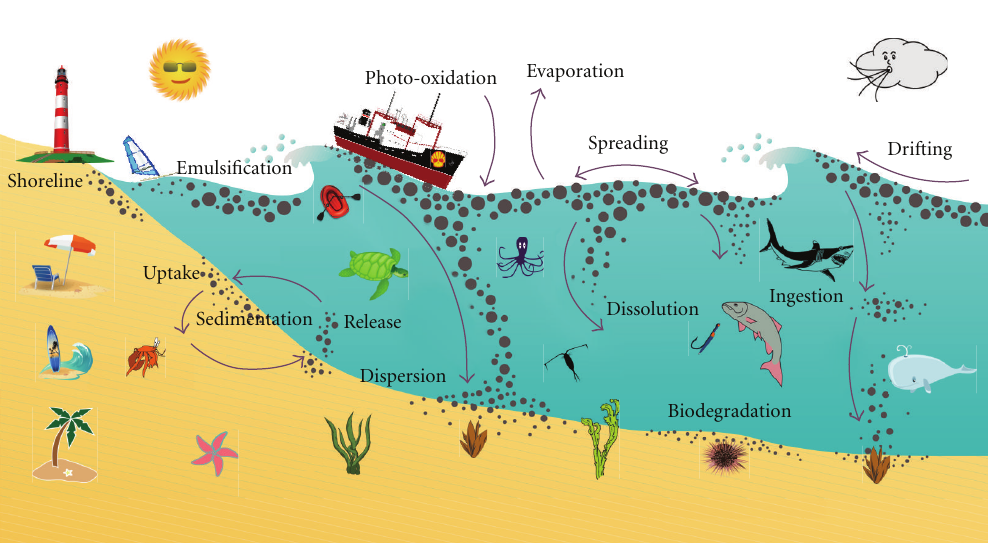
Figure 1: Transport and fate of oil slick in